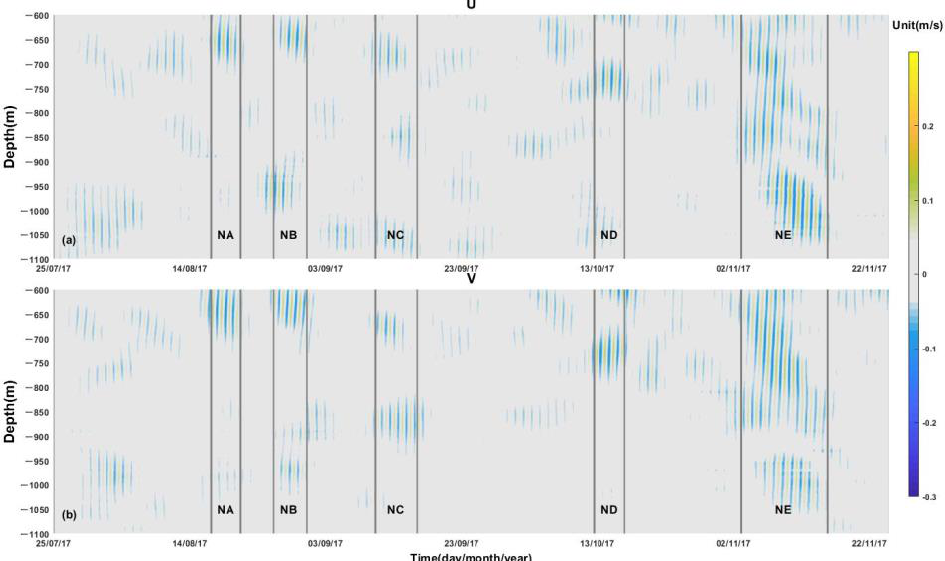
Figure 2. Near-inertial current velocity profiles. In ( a , b ) are shown the U and V components, respectively. The bandpass range used is from 0.8 f 0 to 1.2 f 0 . The gray vertical lines in the figure mark the extent of each NIWs event.